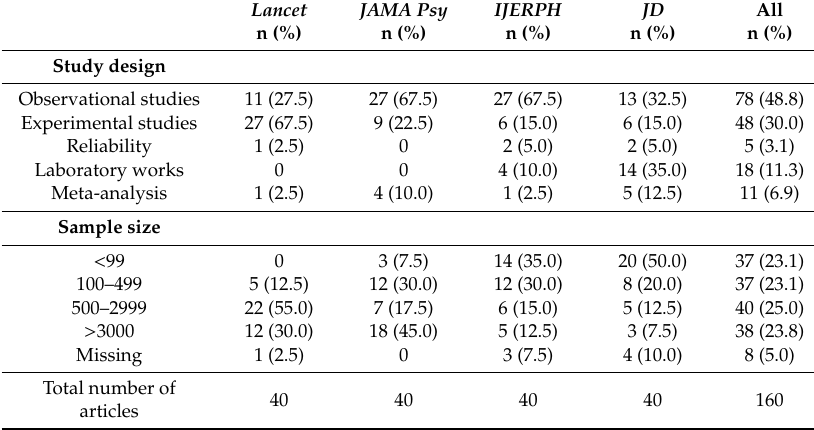
Table 2. Distribution of study design and sample size of the evaluated articles by the publication journal.